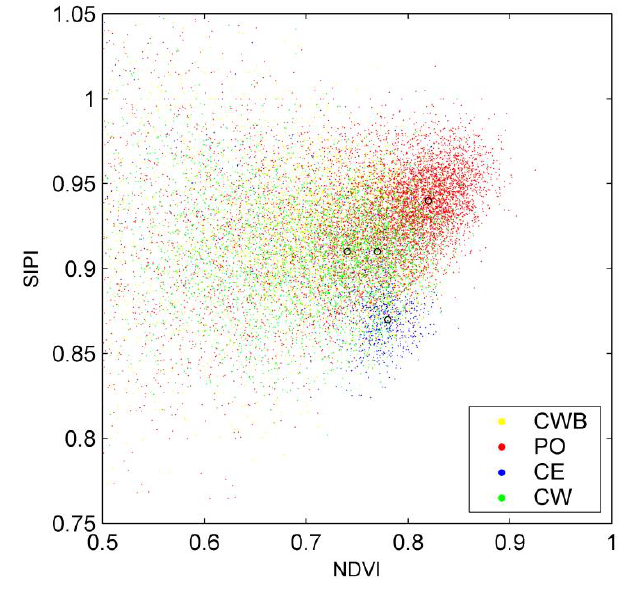
Figure 7. Illustration of tree spectral reflectance characteristics for different tree species based on NDVI and SIPI. The circles indicate the clustering centers